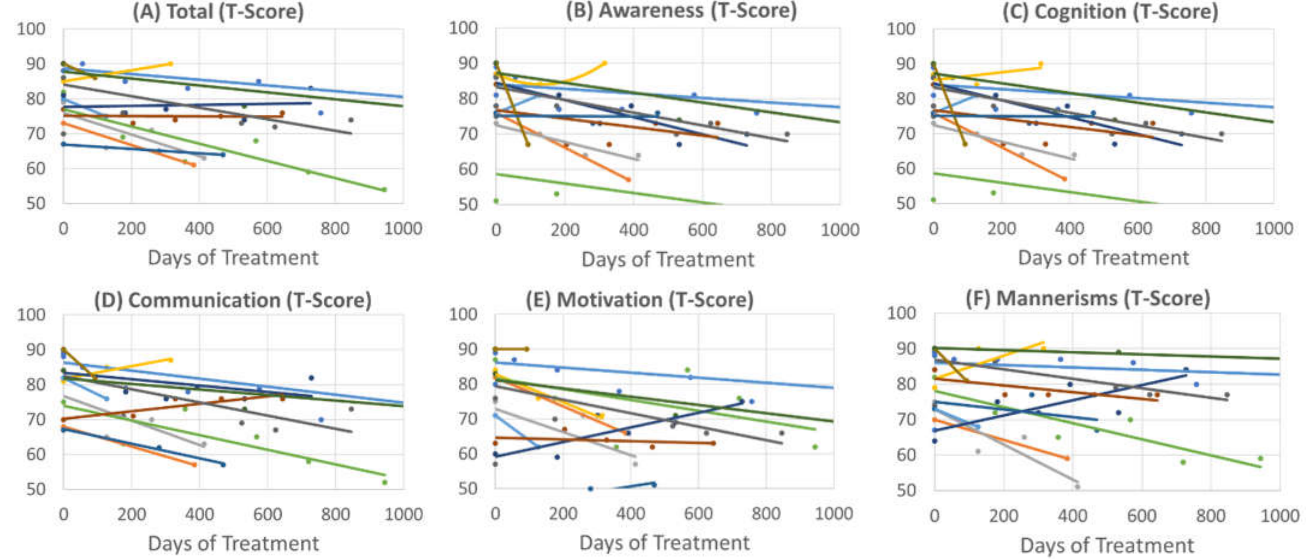
Figure 1. Change in the Social Responsiveness Scale (t-scores) over time with initiation of leucovorin for patients with soluble folate binding proteins: ( A ) Total Score, ( B ) Awareness, ( C ) Cognition, ( D ) Communication, ( E ) Motivation and ( F ) Mannerisms. Each color line represents a single patient.